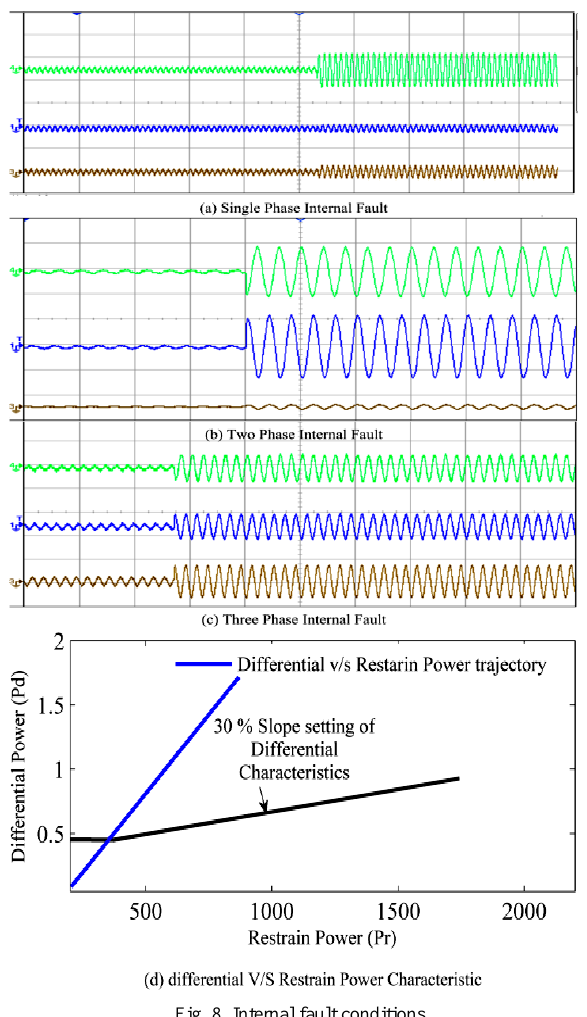
Fig. 8. Internal fault conditions.